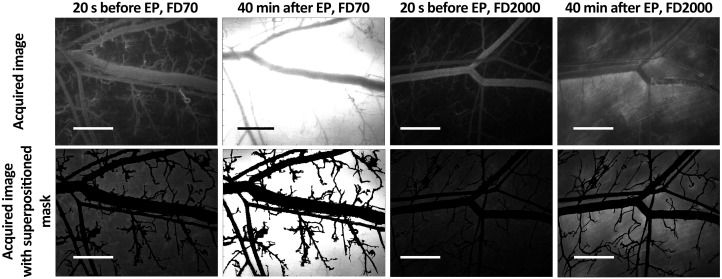
Fluorescent in vivo imaging of FD distribution in the tissue.Fluorescent in vivo imaging of FD distribution in the intra and extravascular space and superposition of the masks used for image analysis. Construction of masks of blood vessels networks enabled to discriminate between the FD that was present in small blood vessels and FD that extravasated into the tissue. Before electroporation (t = 20 s) there was no FD detected outside the blood vessels as seen when the masks were superpositioned on the original image (no FD fluorescence outside the tissue). When the masks were superpositioned on the original image at t = 40 min after EP a high increase of FD fluorescence intensity outside blood vessels was detected. FD70–70 kDa FD, FD2000–2000 kDa FD. The scale bar is 1 mm.